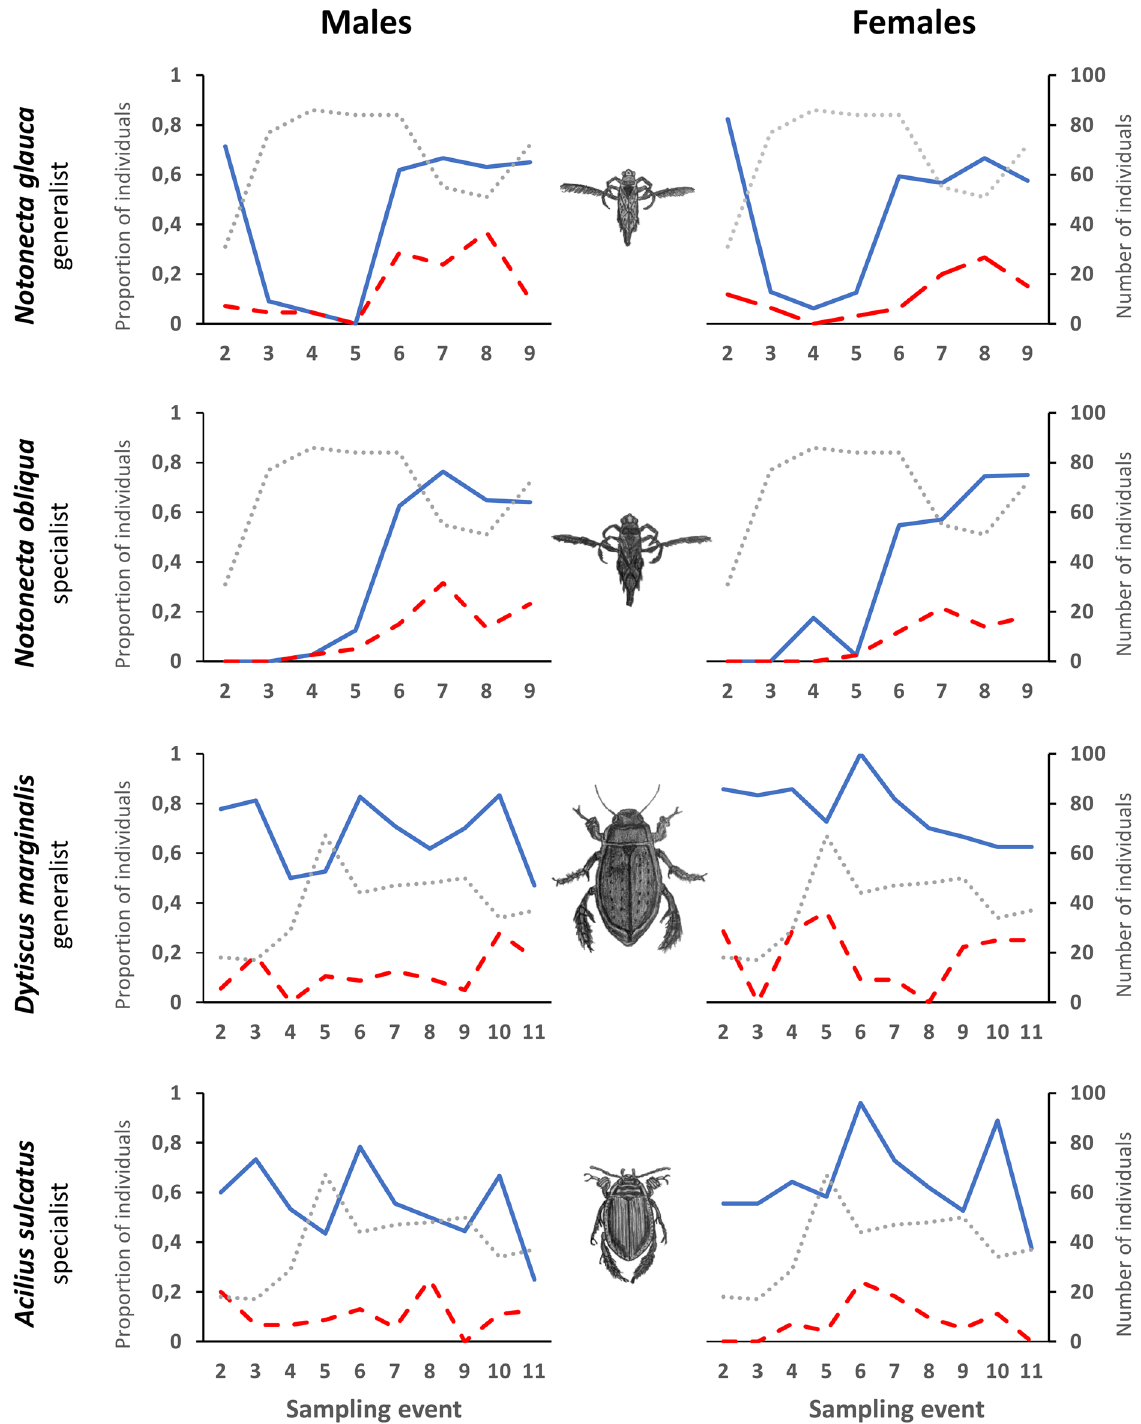
Figure 2. Habitat change frequency over time. Cumulative proportion of individuals changing habitat type between sampling events (blue), and the proportion of individuals opting for non-preferred habitat types (red dashed line; habitat types with occurrence of individuals in less than 15% of all cases) in backswimmers ( Notonecta glauca , N. obliqua ), and diving beetles ( Dytiscus marginalis , Acilius sulcatus ). Additional lines were included to visualize the total densities of individuals (both sexes) occurring in the most preferred habitat type = dotted line (PH; backswimmers: fishless habitats with submersed and floating macrophytes; diving beetles: the sum of individuals found in all preferred